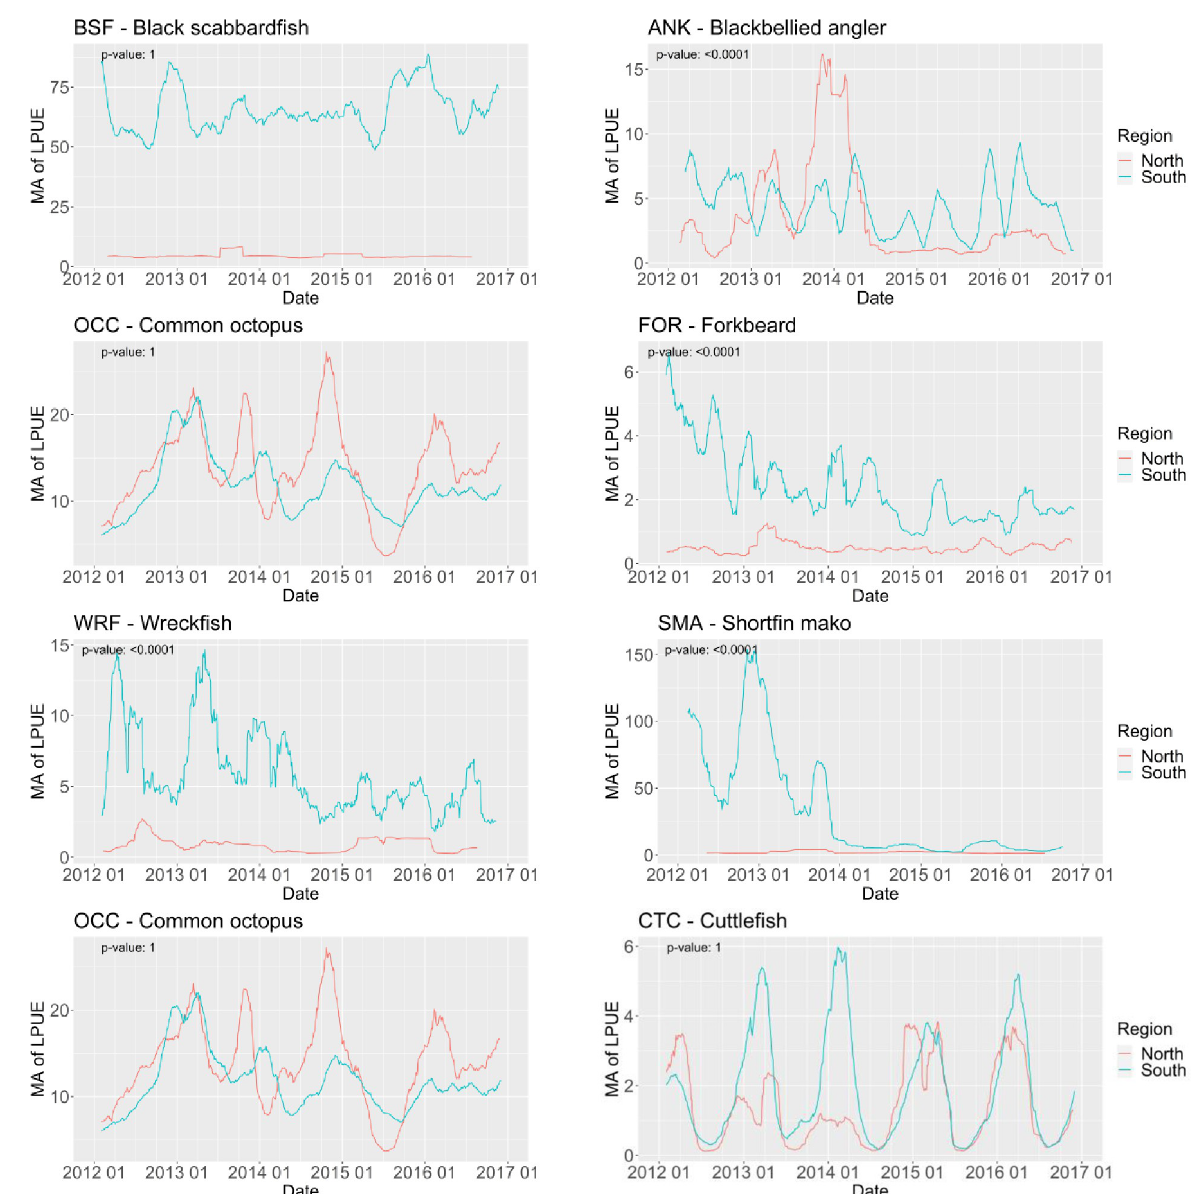
Fig 2. Daily landings per unit of effort (kg LoA-1 trip-1) expressed as moving average (MA) of 44 days (centre of classes plotted) for each species. The p-value of the linear trend is indicated at the top left corner of each plot. Blue and red lines correspond to the south and north regions, respectively. Species: a) black scabbardfish, b) blackbellied angler, c) common sole, d) forkbeard, e) wreckfish, f) shortfin mako, g) common octopus and h) cuttlefish.